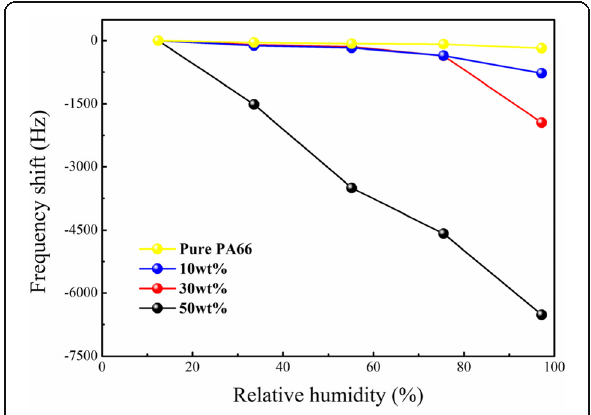
Fig. 3 The relationship between the frequency shift and the corresponding relative humidity at different concentration of CoCl 2 ·6H 2 O on PA66 NFMs measured by humidity ascending